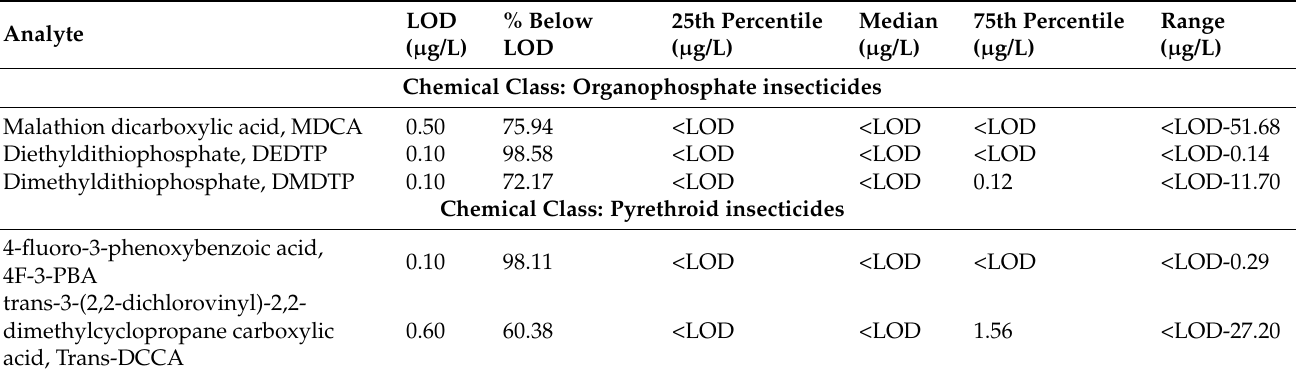
Table A1. Descriptive statistics of pesticide metabolites with over 60% of results below the limit of detection.